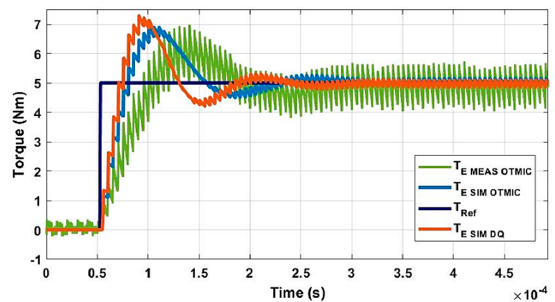
Figure 6. Step response of simulated and measured torque for OTMIC and DQ.